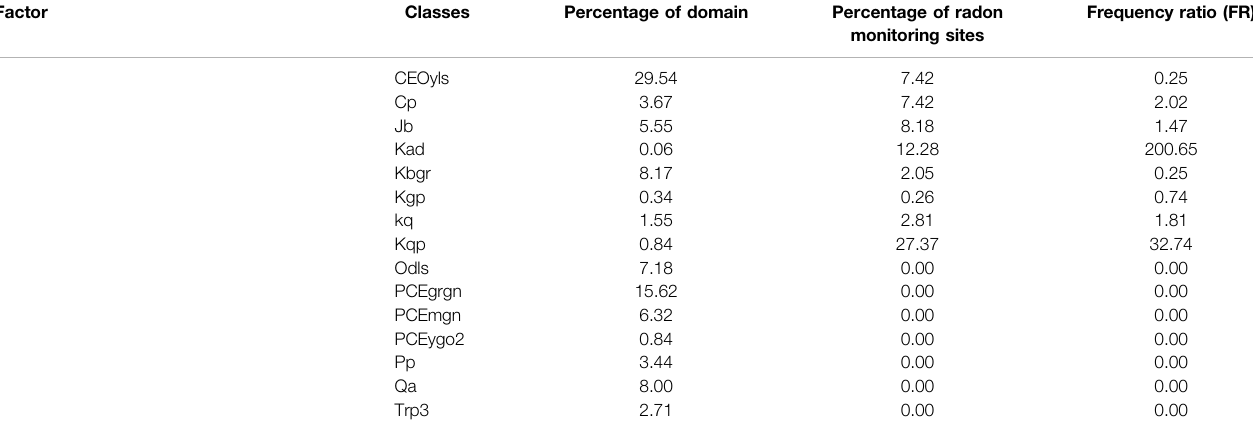
TABLE 3 | ( Continued ) Spatial relationships of predictor variables with the IRC values, determined through FR